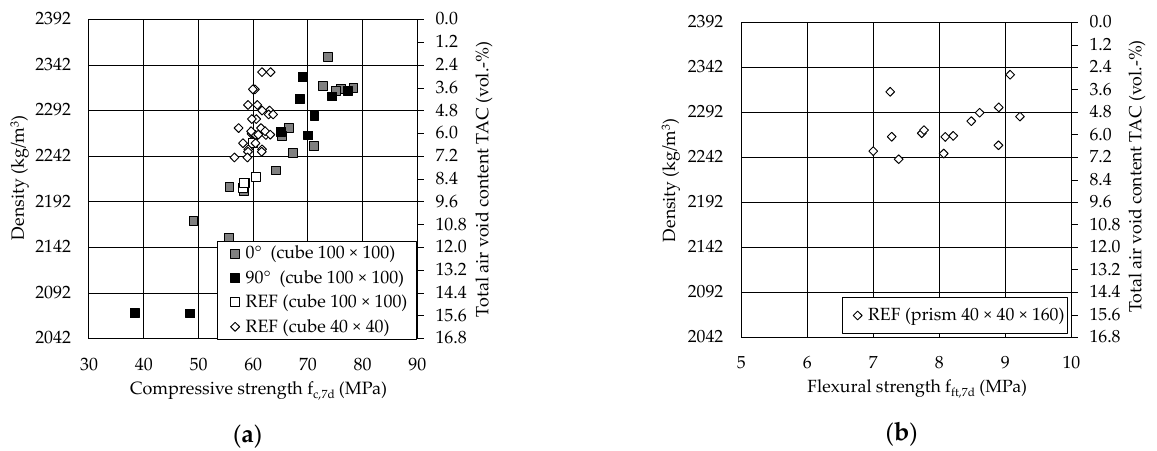
Figure 10. Strength values after 7 d: ( a ) Compressive strength and ( b ) Flexural strength.